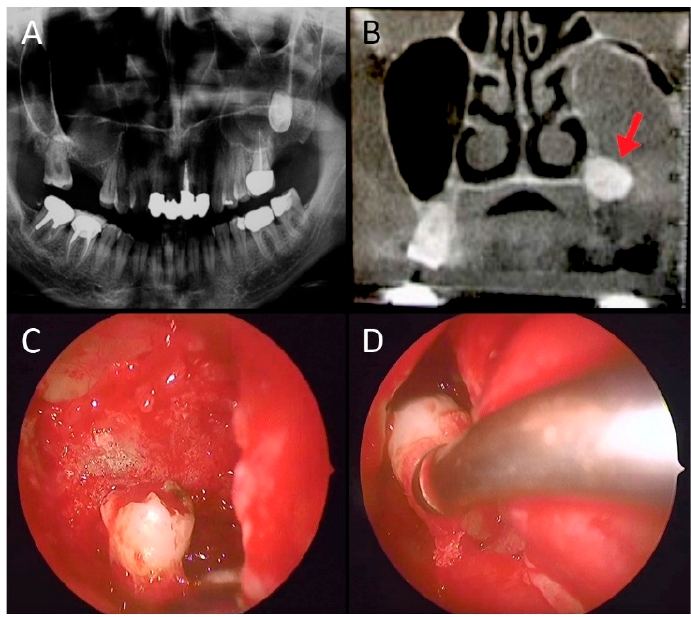
Figure 1. Male, 46 years old, complaining of nasal obstruction, rhinorrhea and foul odor and taste, without dental symptoms. The panoramic X-ray ( A ) and the CT scan ( B ) revealed a large odontogenic cyst of the left maxillary sinus, with an impacted tooth inside (red arrow in ( B )). An exclusive endoscopic endonasal surgical approach was chosen; the tooth ( C ) was therefore removed ( D ) together with the cyst